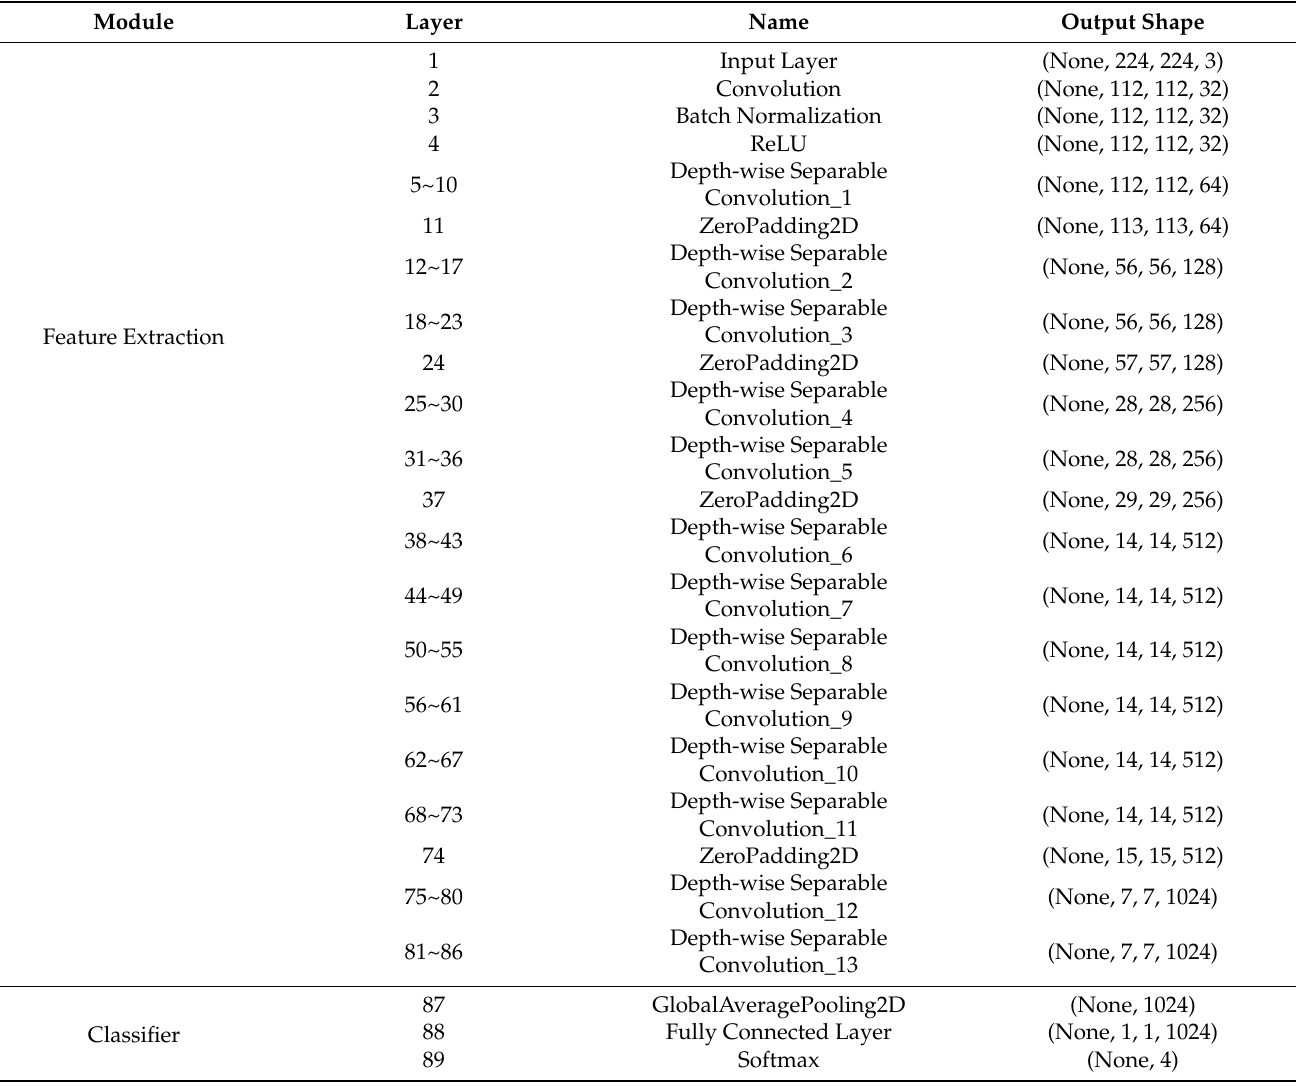
Table 4. Structure of the MobileNet